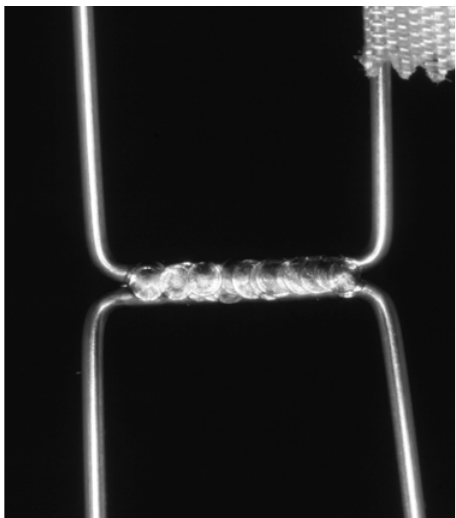
FIGURE 3- 3-mm long joints. Wire material: Forestanit in spring hard quality (diameter 0.9 mm)